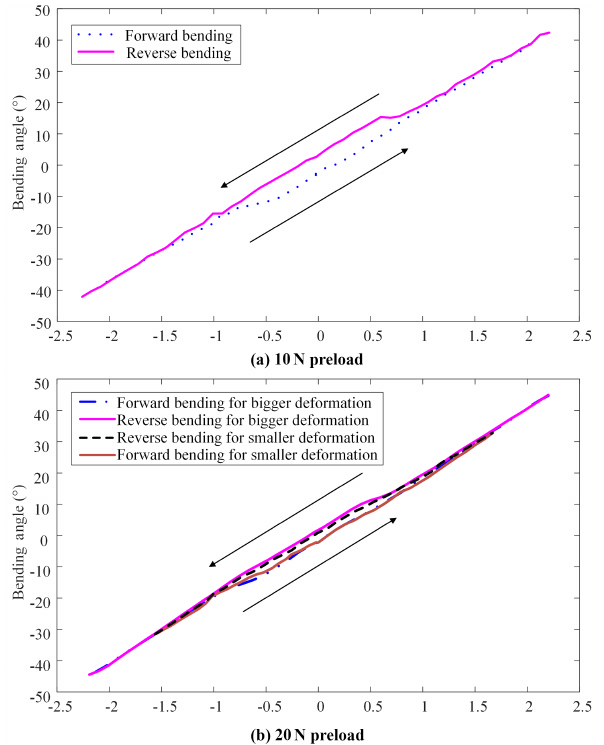
Figure 4. Static experimental results under discrete signal.